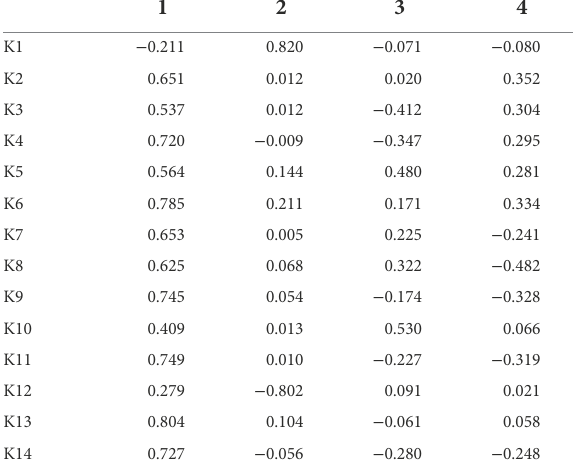
TABLE 4 KMO and Bartlett’s test.